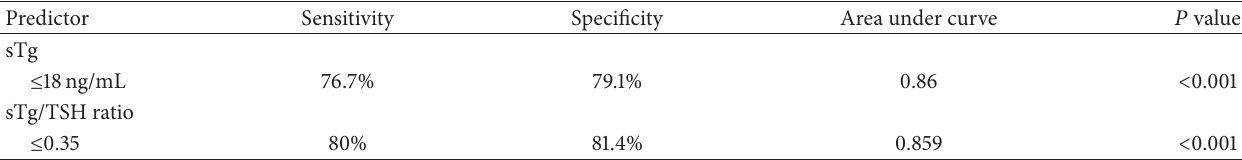
Values with maximum sensitivity and specificity.